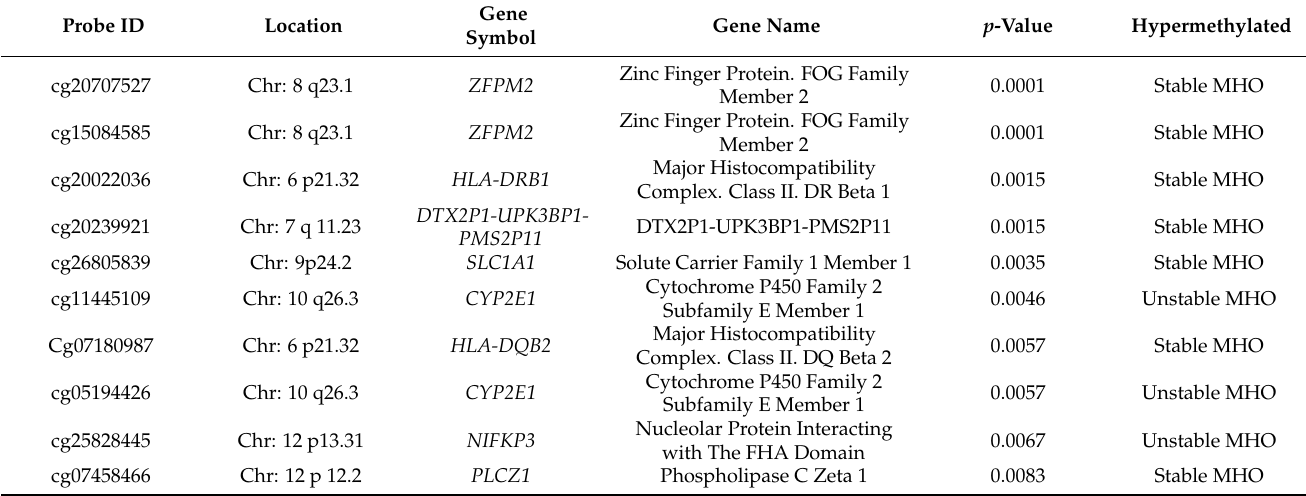
Table 2. The top ten significantly differentially methylated CpG sites in stable MHO and unstable MHO throughout the study. Probe